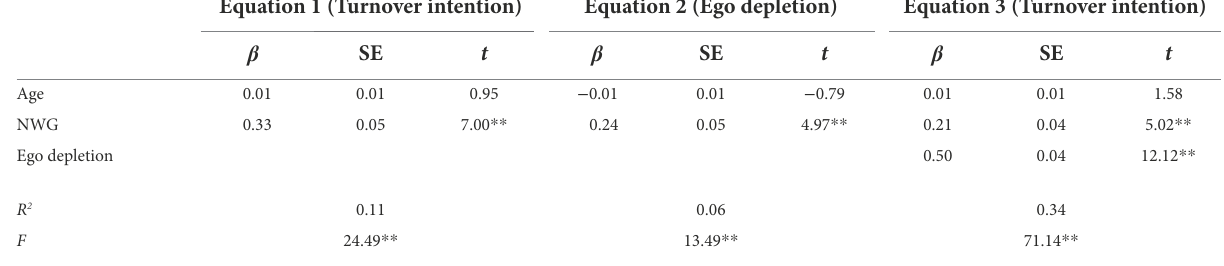
TABLE 2 Mediation analyzes.